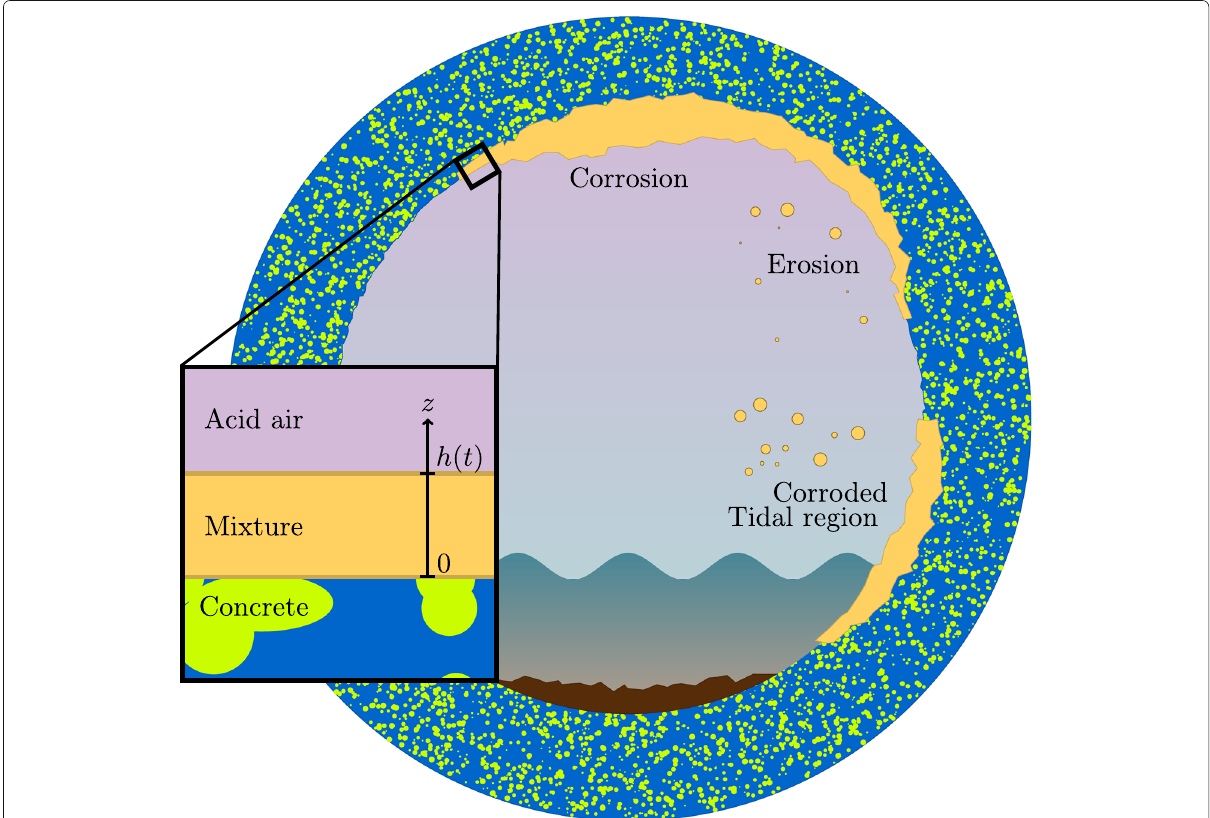
Fig. 1 A concrete sewer pipe is corroded by sulfuric acid containing air at the top and by the acidic sewage at the tidal region of the sewage-air interface. The sulfuric acid is created by biodegradation of bio-matter in sewage. Extended corrosion leads to erosion of the concrete and potentially to sewer pipe collapse. Our model is meant to describe the beginning of corrosion, as shown in the small square, allowing the simplifications from a pipe to a plate layer, as shown in the large square. This simplification reduces a 3-D concrete corrosion model into a 1-D model only dependent on the spatial variable z . The thickness, h ( t ) , of the mixture layer changes over time due to both influx of material and